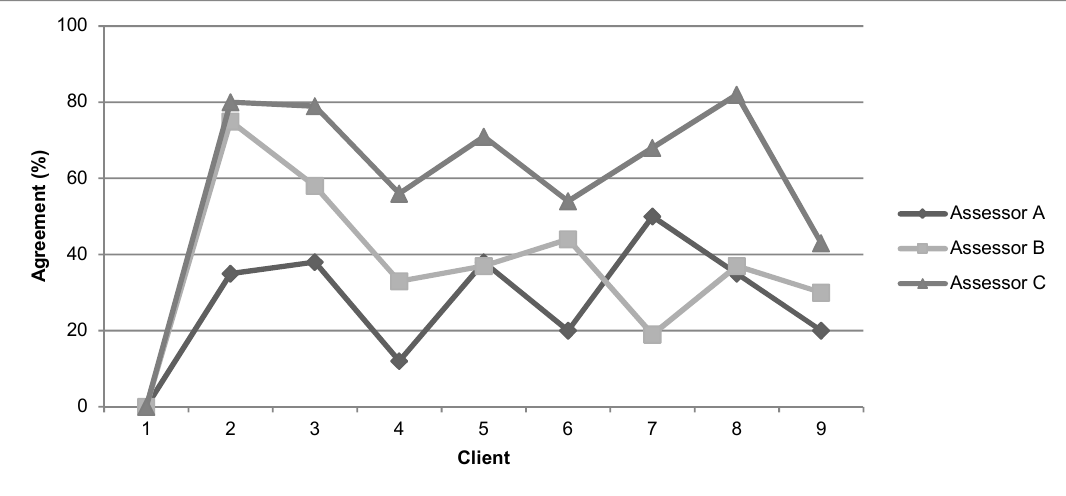
Figure 2: Percentage agreement between script analyses made at 2 times by 3 assessors (intra-assessor